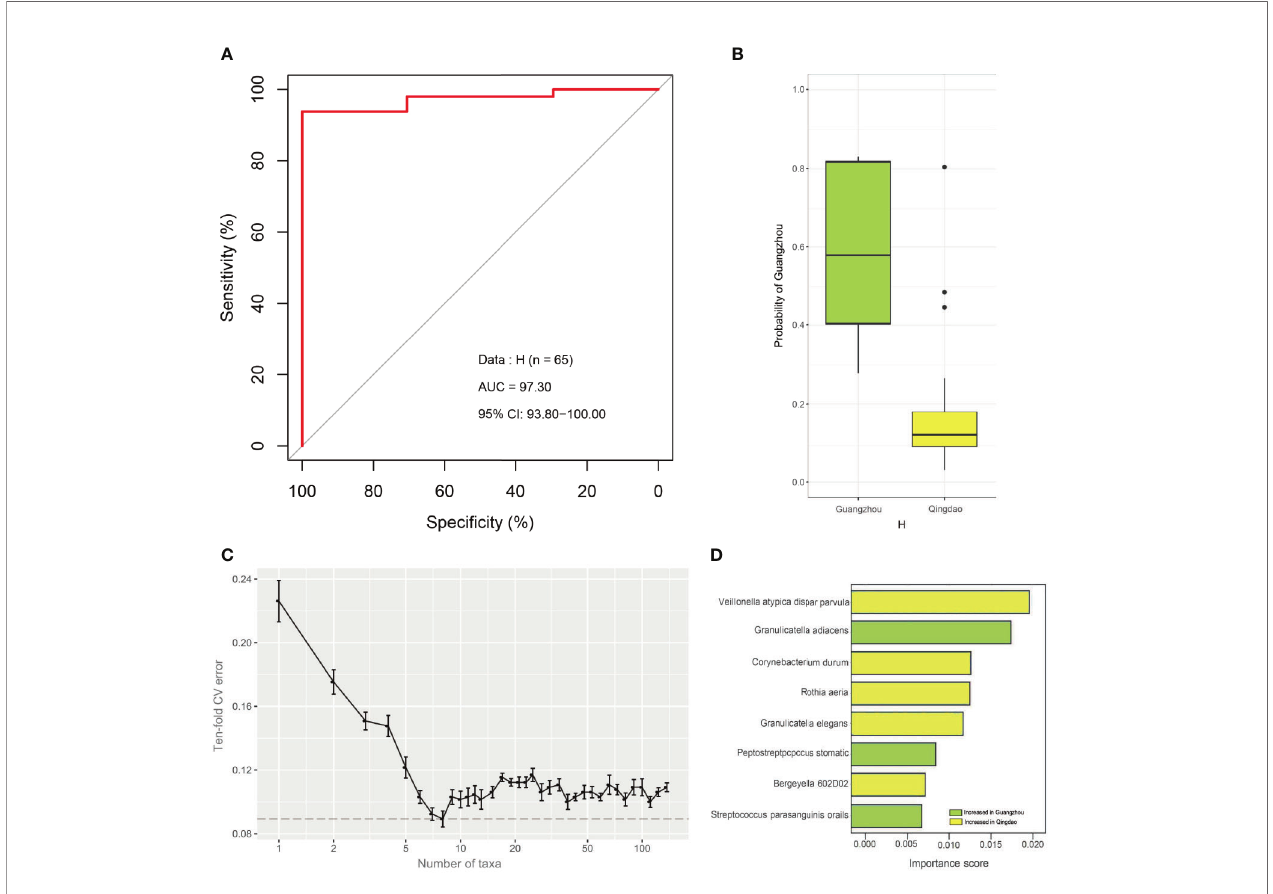
FIGURE 4 | The strong geographical background of the healthy oral microbiota and key drivers. (A) Microbiome can classify the city of origin of healthy samples with a high accuracy. We utilized the Random Forests machine learning algorithm to quantify the city-associated difference in the saliva microbiota from healthy population. City (Qingdao and Guangzhou, China) can be distinguished with high AUC in the random forests model. And the healthy microbiota can predict city- origin with high accuracy (AUC=97.30%). (B) Box plot indicates the prediction probability of Guangzhou city in healthy samples. The probability of Guangzhou was signi fi cantly higher in the Guangzhou samples than in the Qingdao samples in H group. (C) Relationship between the numbers of variables used in the reduced models and the corresponding predictive performance (the error bar denotes SD). (D) The importance score of eight the most discriminating species in the diagnosis model to predict city origin. The bar length at each row indicates relative contribution of the species to the RF